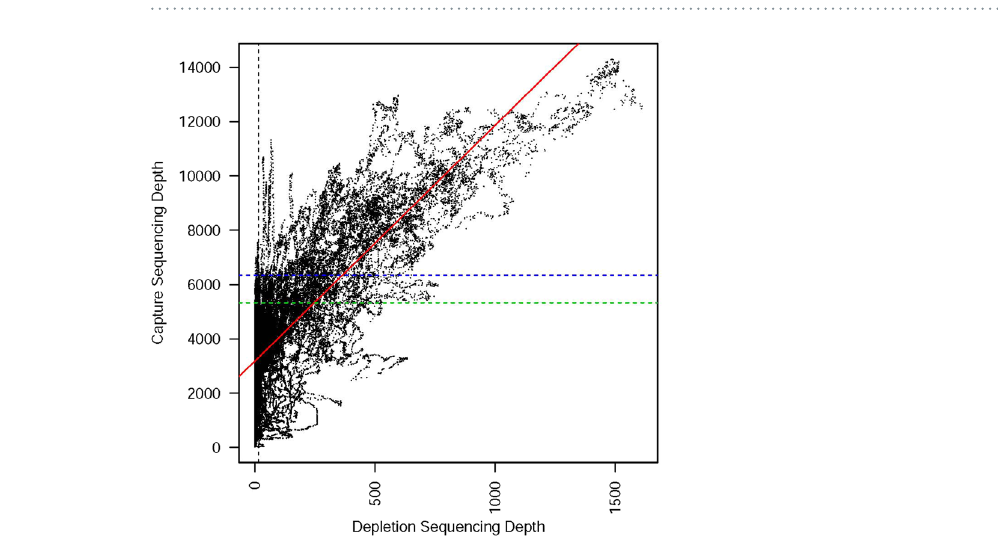
Figure 1. Schematic Depiction of Theoretical Differences Between the Capture and Depletion Data. This schematic depicts the differences between ( A ) a theoretical depletion data set and ( B ) a theoretical capture data set. The depletion data ( A ) is depicted here as low sequencing depth ( < 10X depth) on the Wolbachia genome and 100X depth on a typical single copy Brugia gene. Therefore, a single copy nuwt would have 100X depth while a nuwt with 2 or 3 copies would have 200X or 300X depth, respectively. The ratio of the depth for 1, 2, or 3 copy nuwts relative to Wolbachia endosymbiont DNA would be > 10, > 20, or > 30 respectively. The capture data ( B ) is depicted here as having the same sequencing depth for the Wolbachia genome and a typical single copy Brugia gene (1000X depth). Therefore, a single copy nuwt would have 2000X depth while a nuwt with 2 or 3 copies would have 3000X or 400X depth, respectively. The ratio of the depth for 1, 2, or 3 copy nuwts relative to Wolbachia endosymbiont DNA would be 2, 3, or 4 respectively. This illustrates the effects of two important factors in the actual datasets examined in this study: (a) absolute sequencing depth (where capture depletion) and (b) the ratio of the sequencing depth for a Wolbachia sequence found as a nuwt relative to the same sequence found in the endosymbiont genome (where depletion capture).